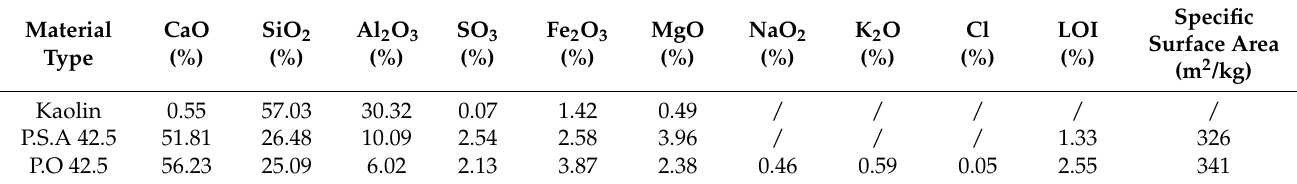
Table 1. Basic chemical properties of the experimental